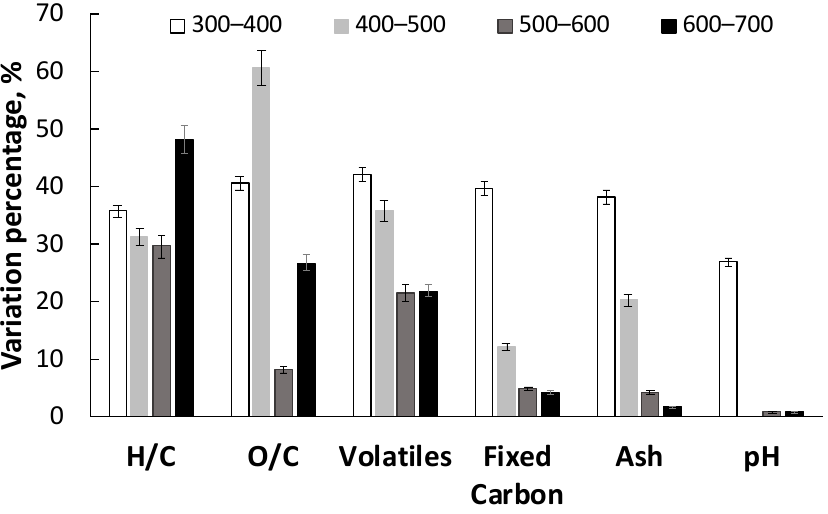
Figure 5. Absolute value of the percentage variation in LRR characteristics for a temperature change of 100 °C.